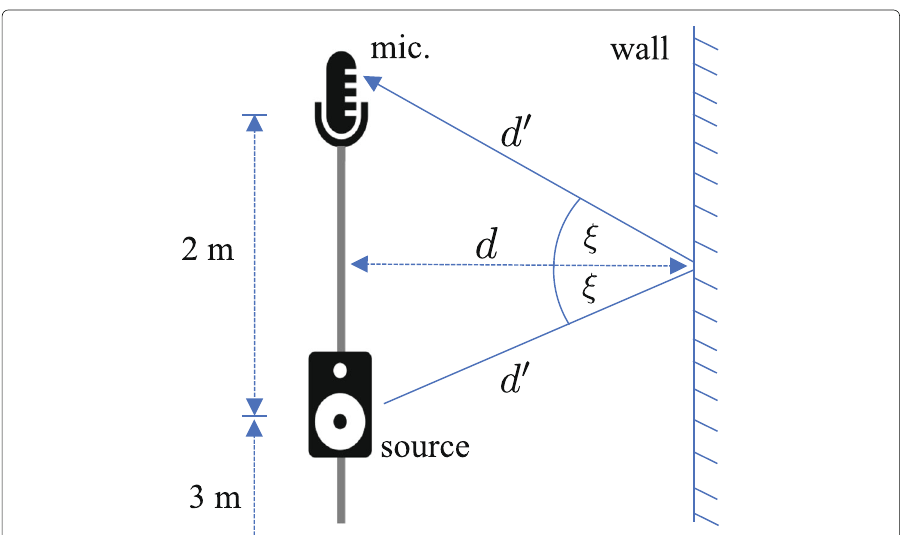
Fig. 9 The microphone-source-wall configuration used in the RIR simulator, for one of the walls. The distance between the robot to the wall is d while the overall propagation distance of the wave is 2 d (cid:8) . The angle of incidence is denoted by